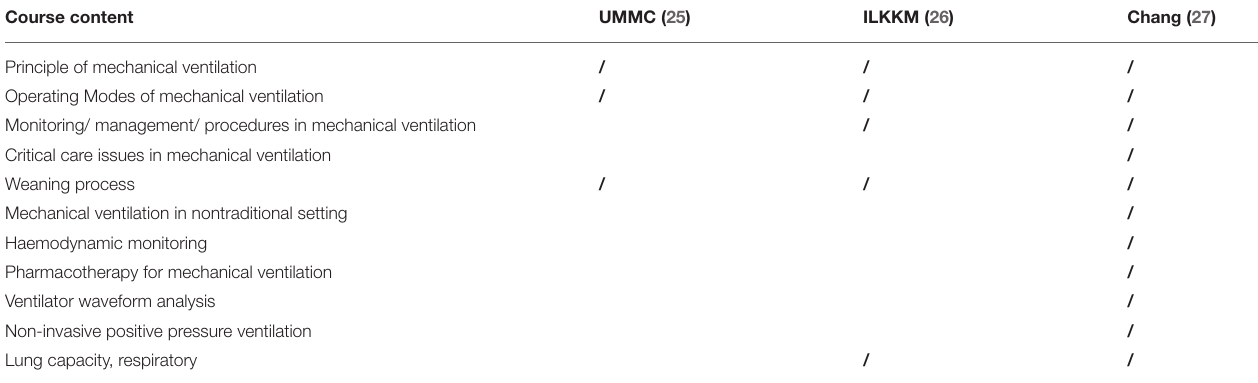
TABLE 1 | Comparison of course content for